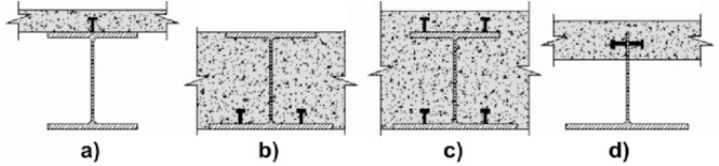
Figure 3. Position of stud